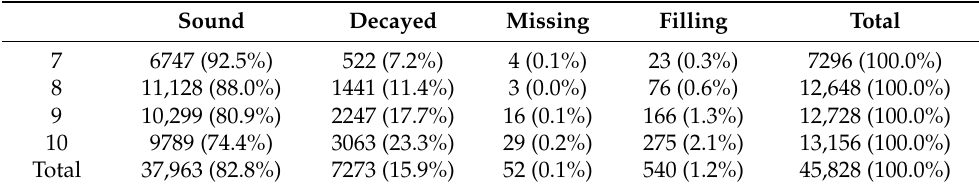
Table 2. Status of sound, decayed, missing and filled PMFs by age [n (%)].